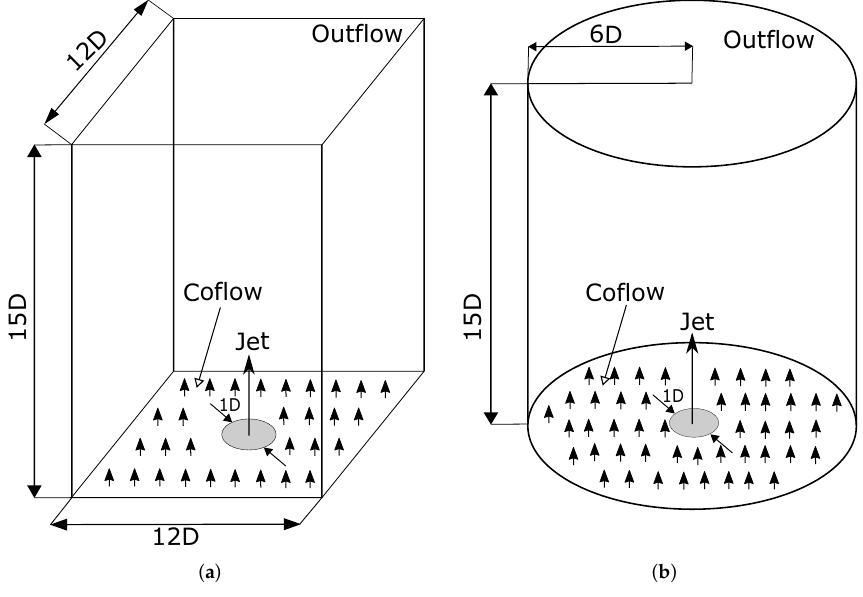
Figure 1. Computational domains: Cartesian ( a ) and cylindrical ( b